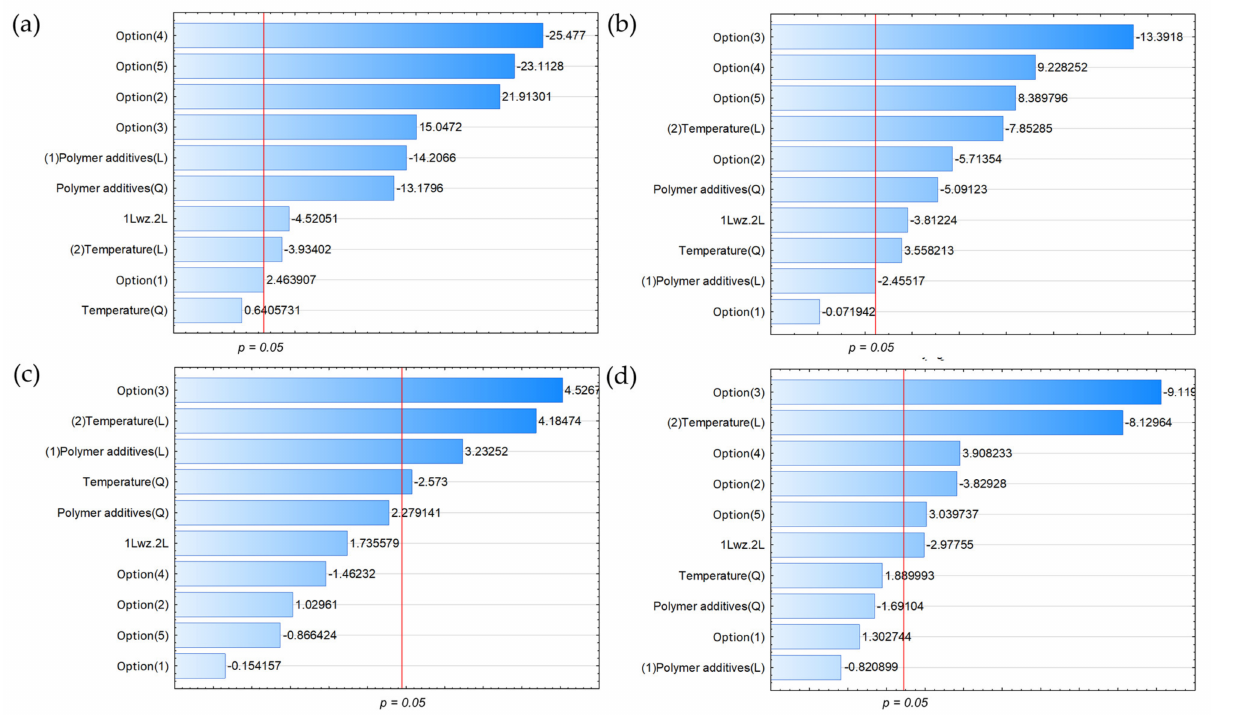
Figure 3. Pareto charts for ( a ) CO, ( b ) CO 2 , ( c ) LHV, and ( d ) density (all variables characterised by bars exceeding the p = 0.05 limit had a statistically significant effect on the parameters under